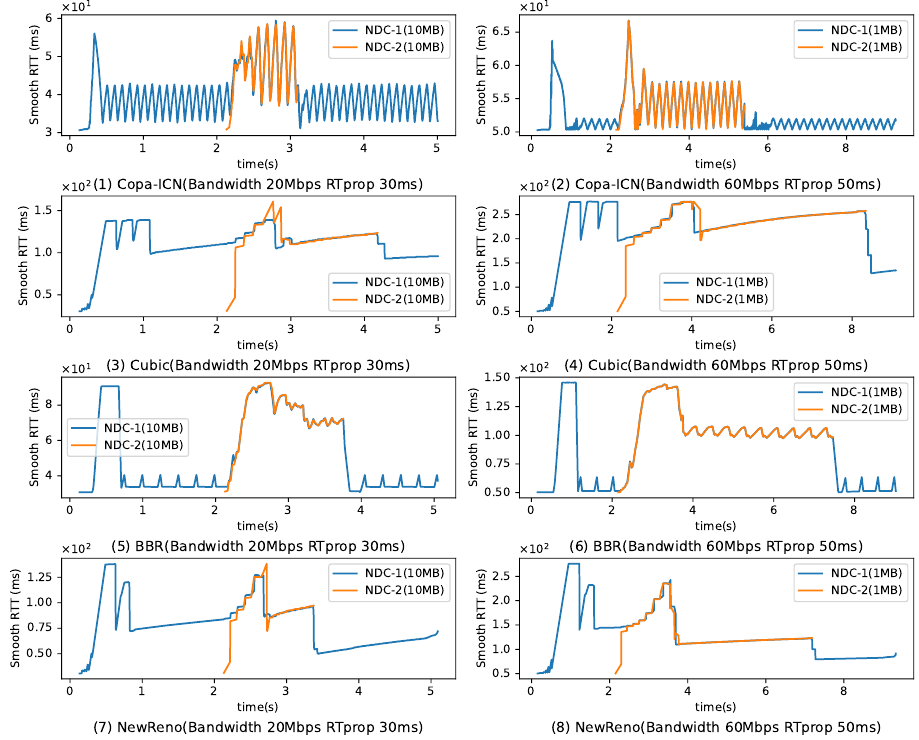
Figure 8. Variation of smooth RTT over time for different factors (algorithm, bottleneck bandwidth, RTprop, and NDC size).